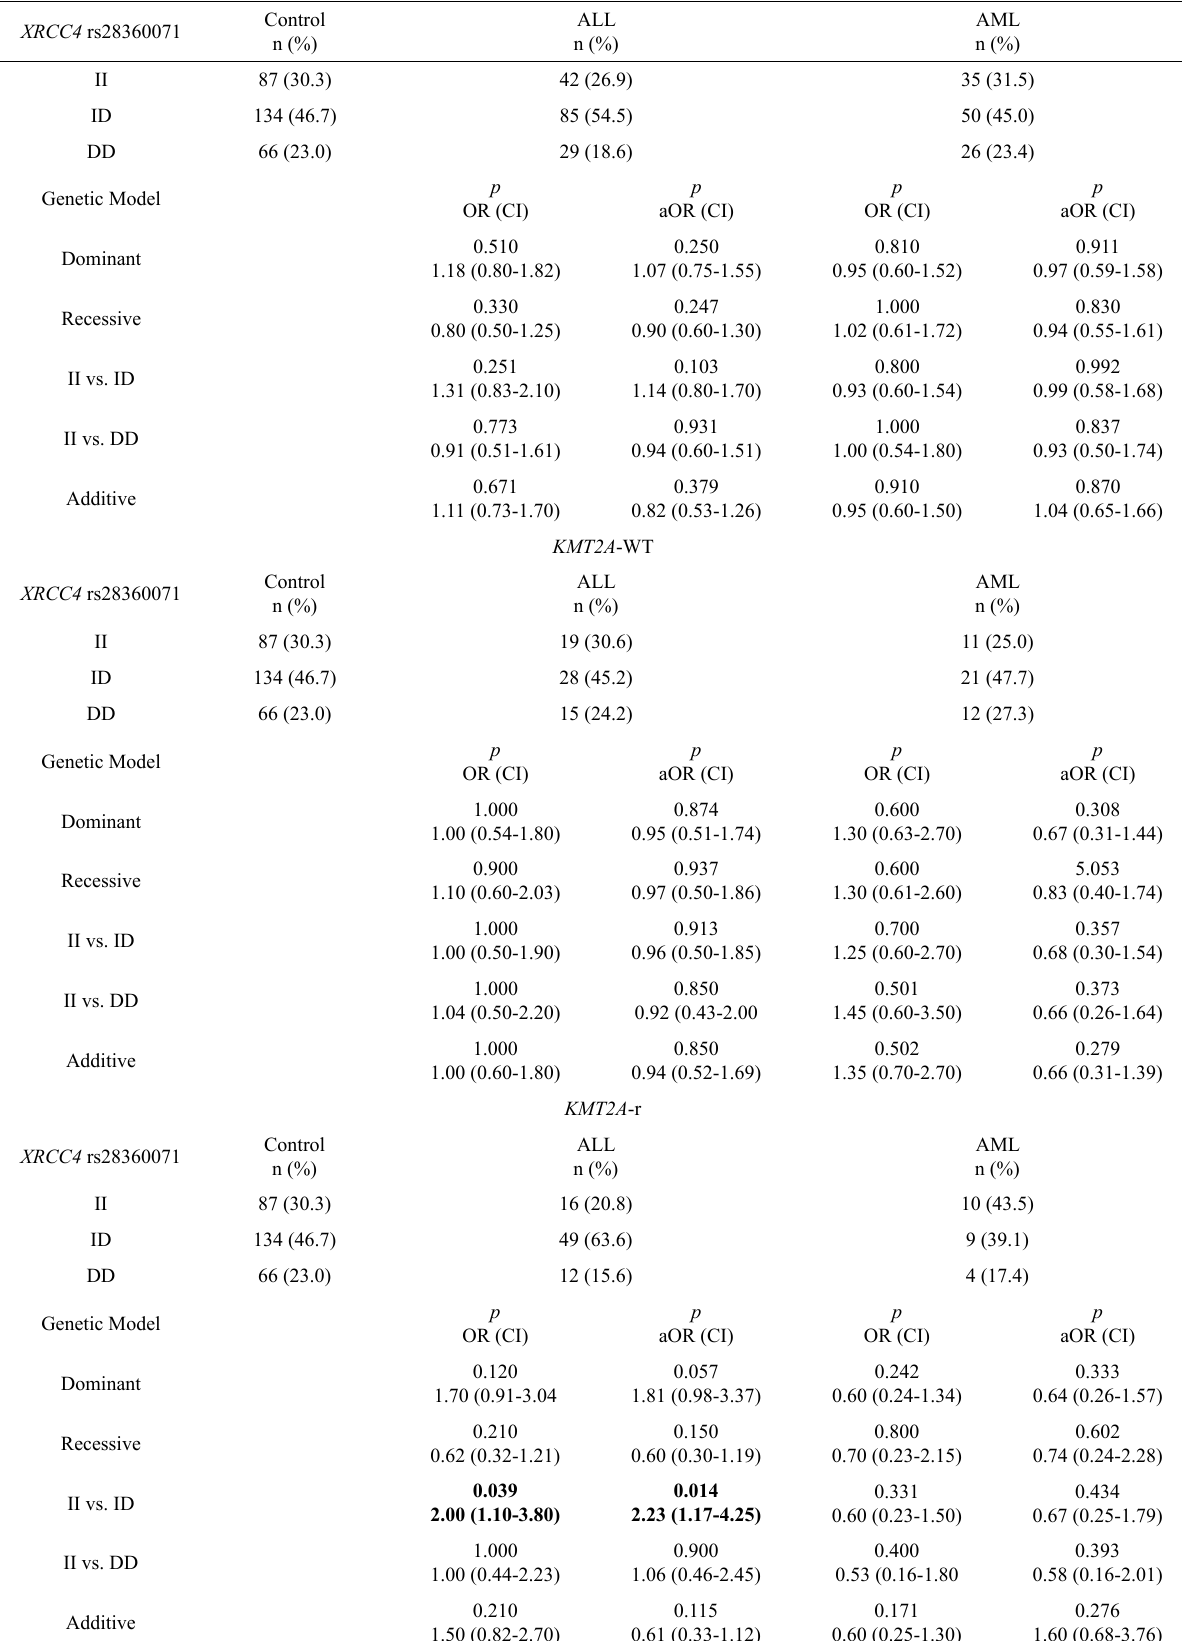
Table 2 – Genotype frequencies for XRCC4 rs28360071 in EAL subtypes and KMT2A